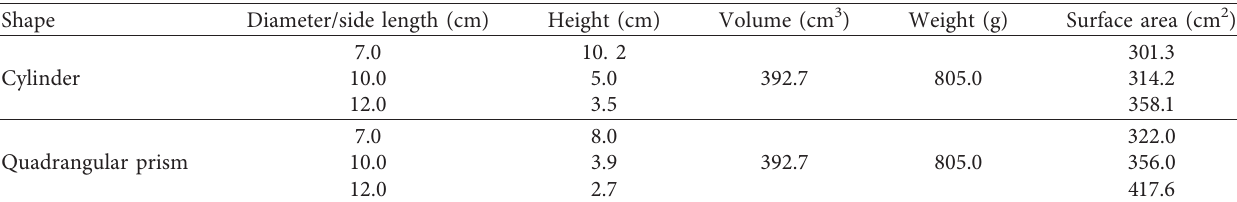
Figure 1: Soil samples, (a) cylinder samples, (b) quadrangular prism samples. Table 2: The initial conditions of the soil